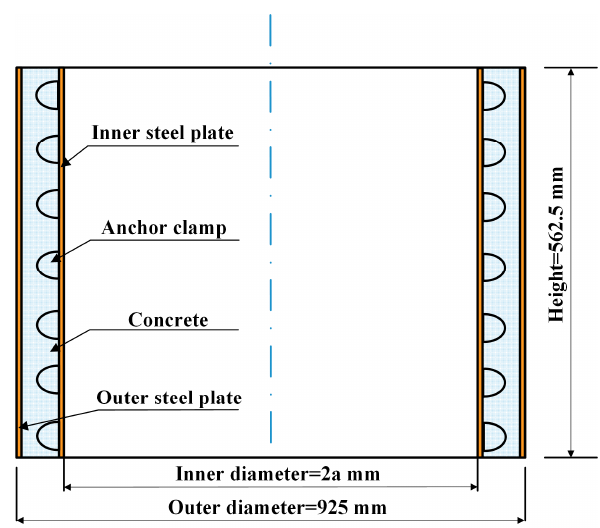
Figure 1. Profile of the shaft lining model specimen . Figure 2. Anchor clamps welded onto the surface of the inner steel plate.